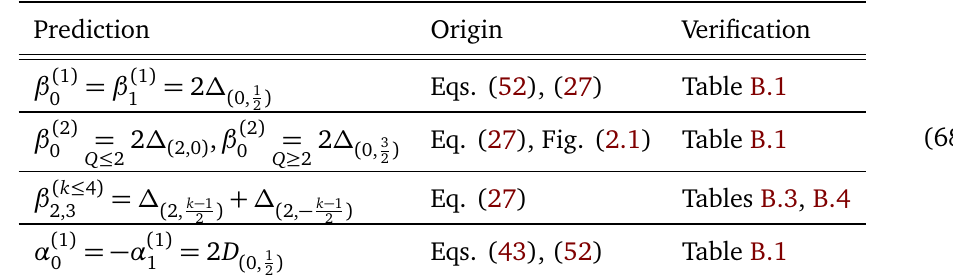
, R at Q = 2, compared with 1 2 3